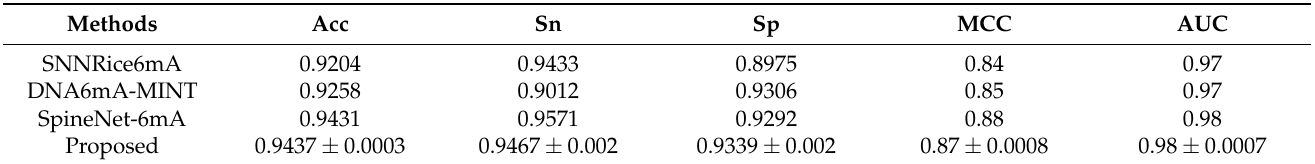
Table 1. Performance comparison of ENet-6mA with other state-of-the-art methods using five-fold cross-validation testing.